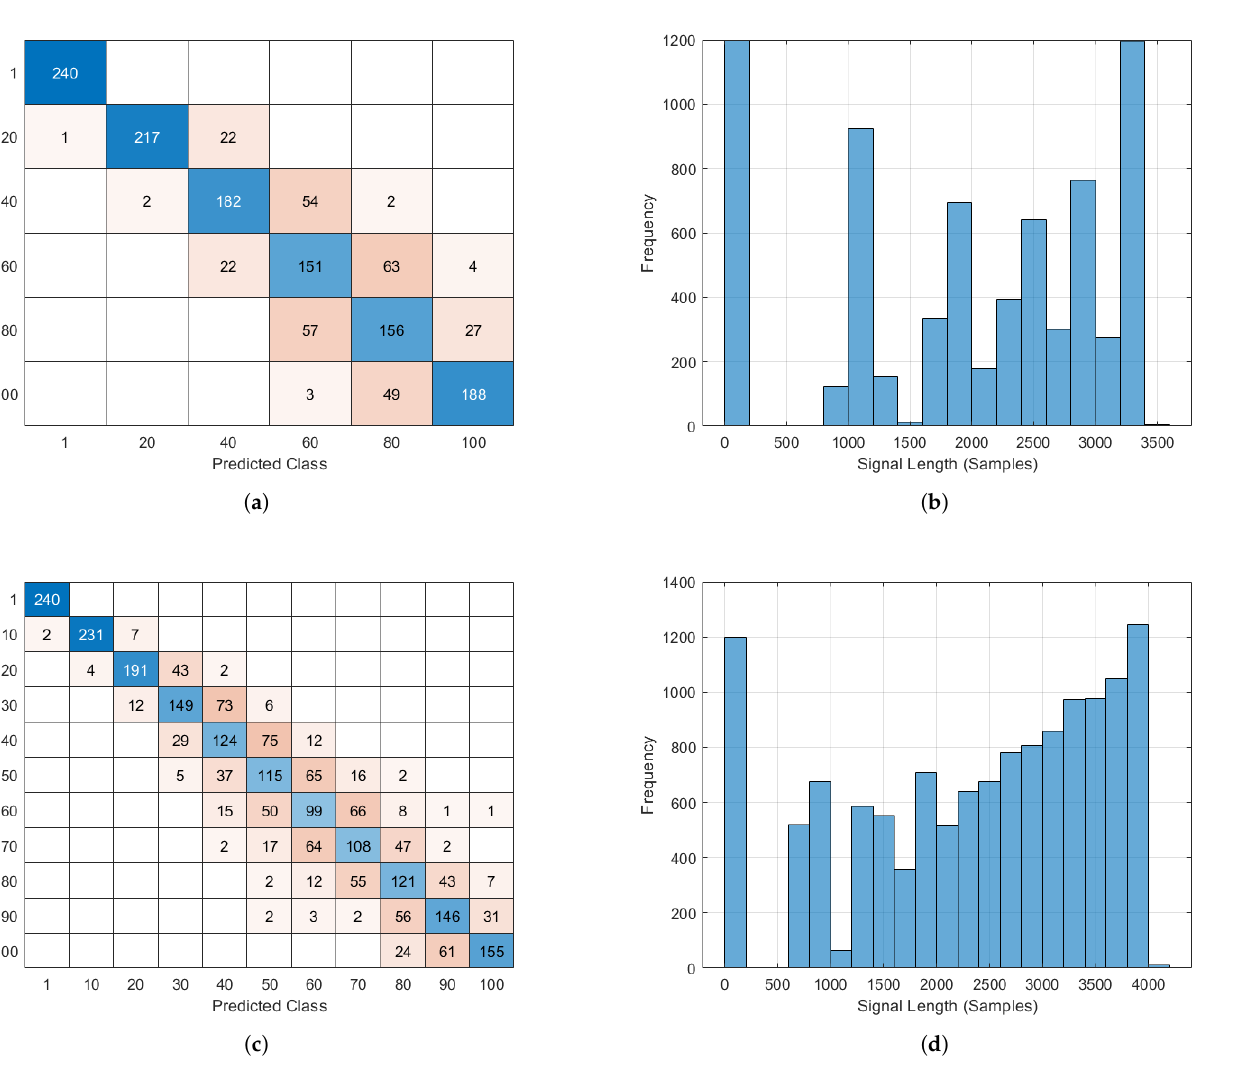
Figure 3. Wavelet scattering for feature extraction using the SVM as a classifier. ( a ) Confusion chart with train set, 5040 samples; validation set, 240 × 6 = 1440 samples; test set, 1080 samples; test accuracy 78.75%; ( b ) trimmed echo signal histogram that represents the set of data used in experiments. There were a total of 7200 samples of six classes with lengths measured in milliseconds; ( c ) Confusion chart with train set, 9240 samples; validation set, 240 × 11 = 2640 samples; test set = 1980 samples; test accuracy 74.15%; ( d ) Trimmed echo signal histogram that represents the set of data used in experiments. There were a total of 13,200 samples of 11 classes with lengths measured in